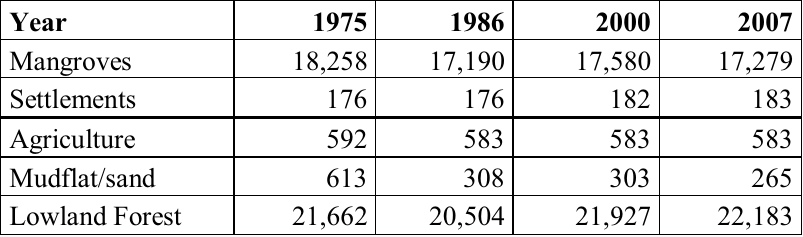
Table 2. Cameroon estuary spatial change in area of vegetation and landuse cover